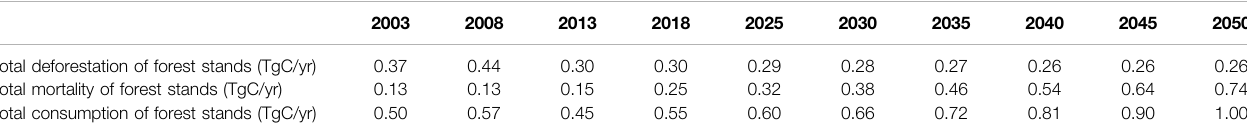
TABLE 4 | Trends in the total consumption of tropical forest stands in Hainan Island from 2003 to 2050.